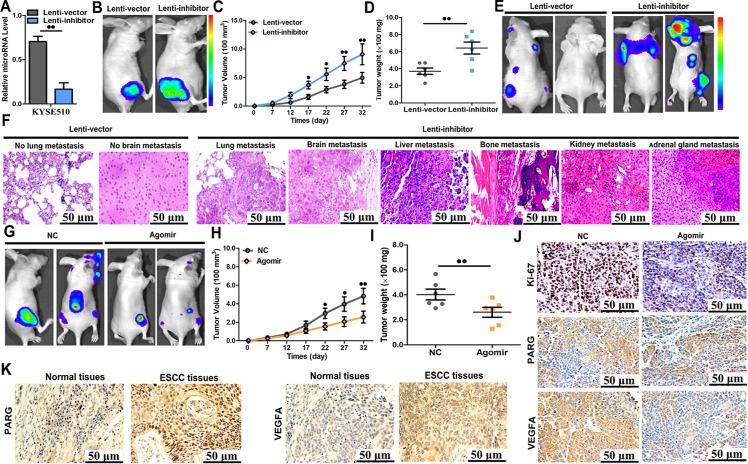
Knockdown of miR-652-5p promoted tumour progressionin vivo.(A)The level of miR-652-5p in KYSE510 cells stably transfected with lenti-inhibitor and control vector. (B-D) KYSE510 cells stably underexpressing miR-652-5p were injected subcutaneously into mice(n = 5 per group). Tumour volume and weight were examined using in vivo luciferase imaging on the final day of analysis. (E-F) Metastatic nodules were shown in bones, brains, lungs, liver, kidneys and adrenal glands of mice inoculated with miR-652-5p-deficient cells or control cells. (G-I) Nude mice were subcutaneously injected with KYSE510 cells and synchronously treated with miR-652-5p agomir or control miRNA (n = 5 per group) by local injection to treat tumour every 7 days. Tumour weight and volume were assessed. (J) Immunohistochemistry analysis for Ki67, PARG, and VEGFA in tumour tissues from two groups of animals. (K) The expressions of PARG and VEGFA in OSCC tissues samples (n = 103) and matched normal tissues (n = 103) were detected by immunohistochemical staining. Data from triplicate experiments are presented.